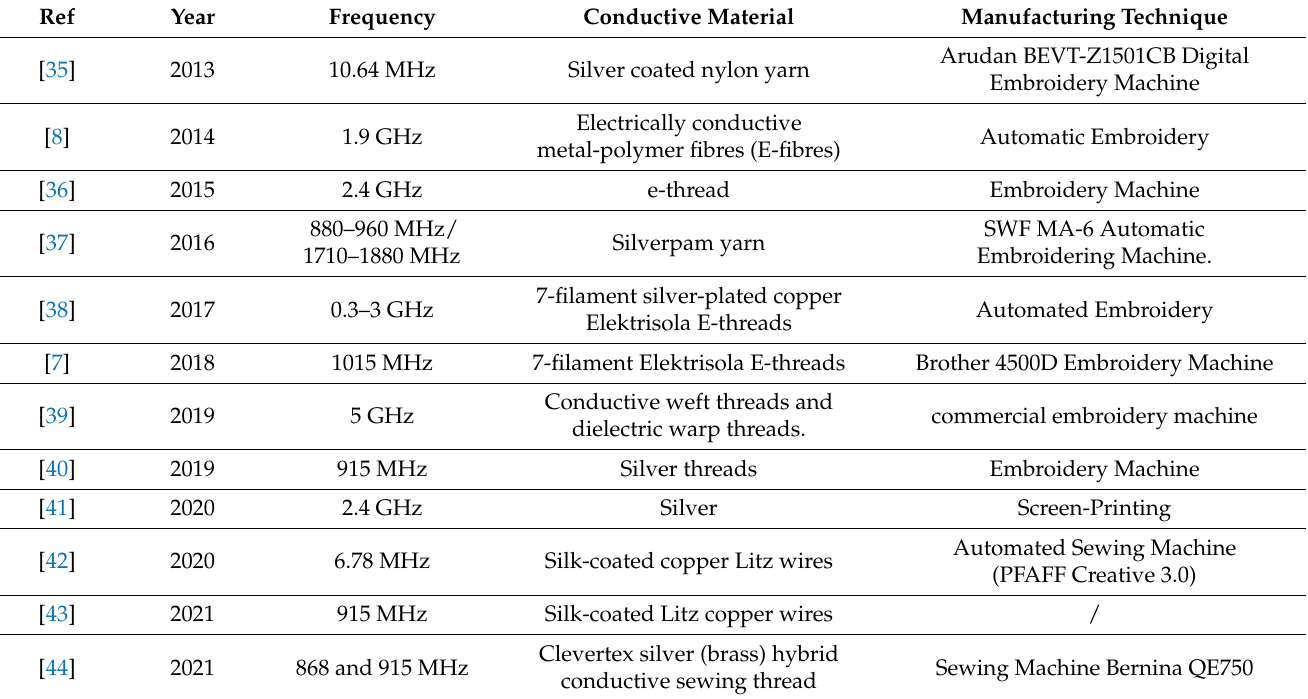
Table 4. Recent research in embraided